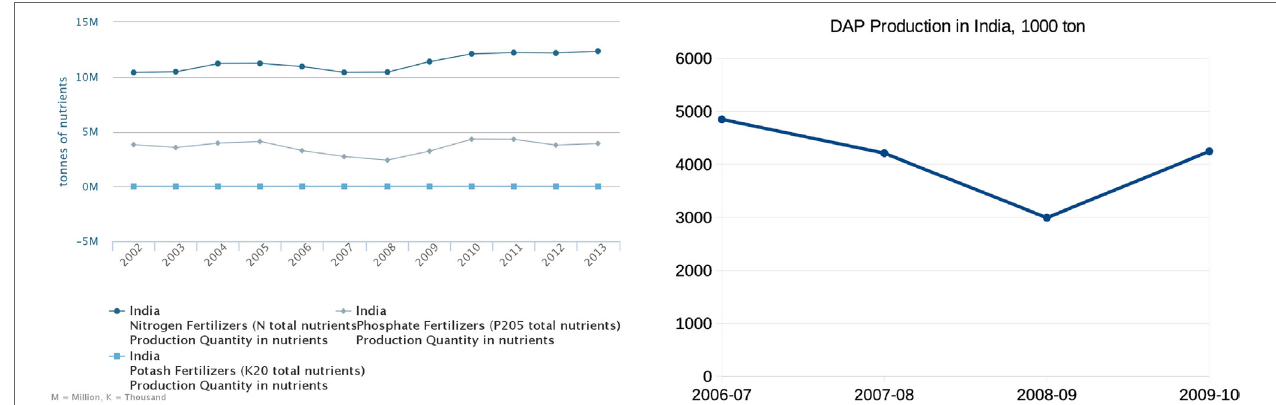
FigUre 4 | Production of fertilizers in India according to FAOSTAT (left panel) and specifically diammonium phosphate production in India according to the Department of Fertilizers of the Ministry of Chemicals and Fertilizers of India (right